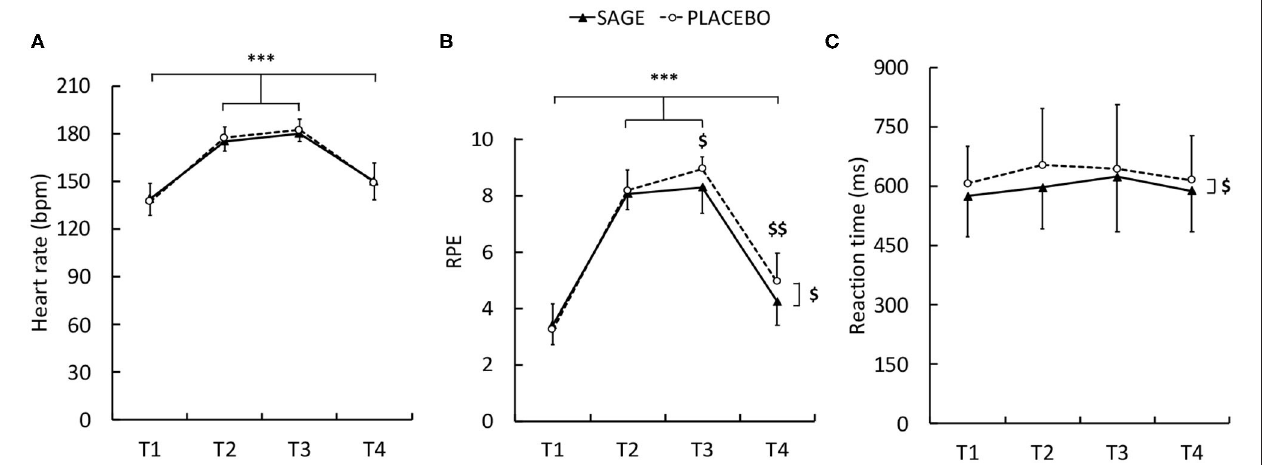
FIGURE 4 | Heart rate (A) , RPE [rate of perceived exertion, (B) ], and reaction time (C) with SAGE and PLACEBO supplementations during the different tests. T1, T2, T3, and T4 were tests following warm-up, first and second fatiguing stages, and recovery, respectively. *** significant difference between tests whatever the supplementation ( P < 0.001). $ significant difference between the supplementation for a given time point (RPE) or main effect (reaction time) ( P <